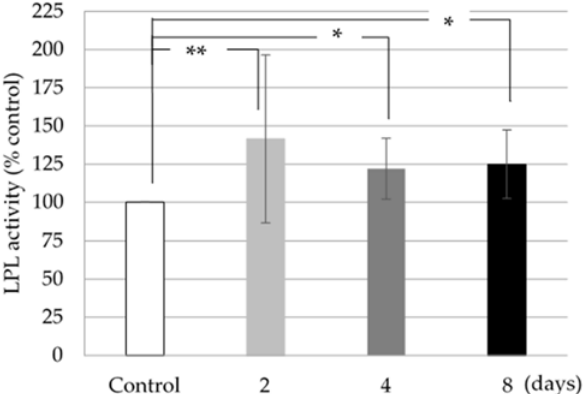
Figure 3. Effect of ISLCs on the lipoprotein lipase activity of 3T3 ‐ L1 cells 2, 4, and 8 days after dif ‐ ferentiation. The cells were cultured in medium containing 1.0 mg/mL ISLCs. The cells in the me ‐ dium without ISLCs were used as a control. Values are expressed as the mean ± SD; * p < 0.05, ** p < 0.01, compared to control cells.